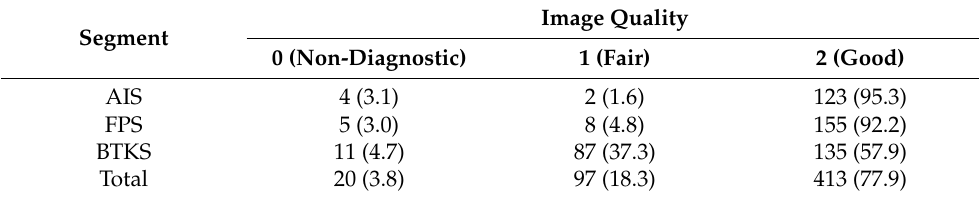
Table 2. DE-CTA image quality.